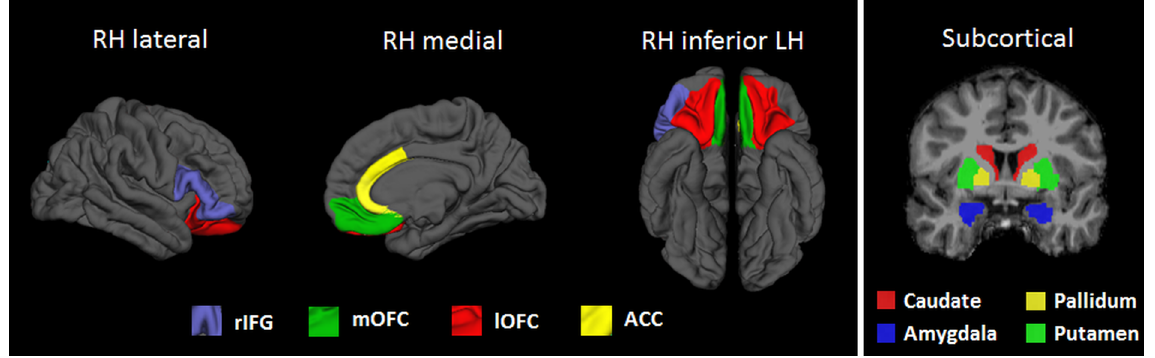
Figure 1. Cortical and subcortical anatomical target regions of interest (ROIs) for this study. LH: Left hemisphere; RH: Right hemisphere; rIFG: Right inferior frontal gyrus; LOFC: lateral orbitofrontal cortex; MOFC: medial orbitofrontal cortex; ACC: Anterior cingulate cortex.